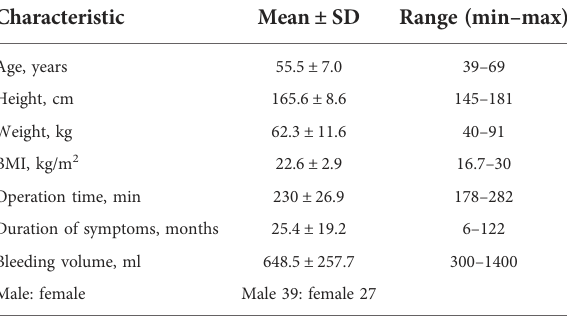
TABLE 1 Basic characteristics of patients with thoracic ossi fi cation of the ligamentum fl avum.